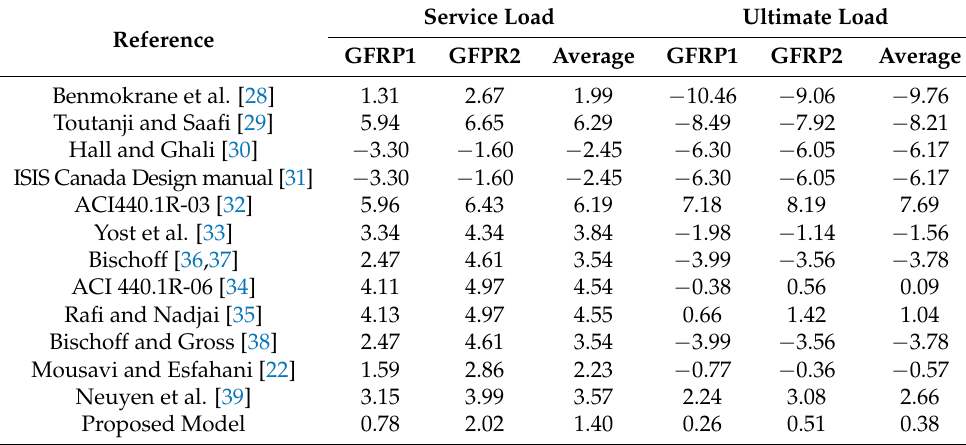
Table 6. Comparison of analytical deflections with experimental values at service load and ultimate load of GFRP specimens.